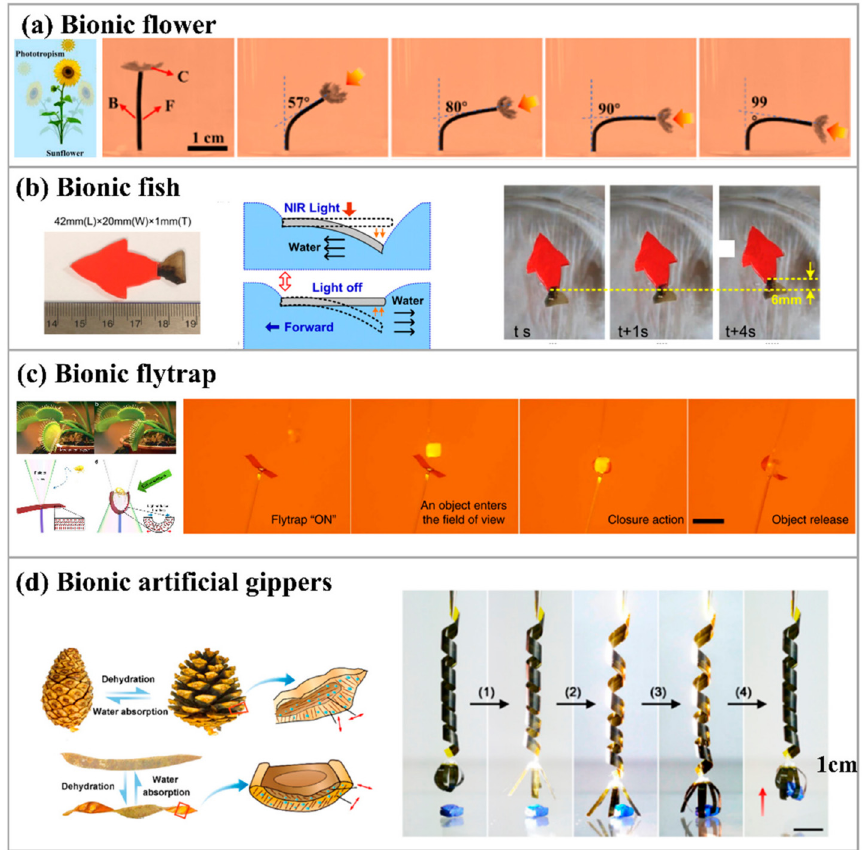
Figure 9. Nature-inspired light-powered soft robot. ( a ) Bionic flower prepared by flexible actua- tor [93]. Permission from RSC Publishing. ( b ) Fishtail-inspired robotic fish actuator design [83]. Permission from American Chemical Society. ( c ) Grasping robot inspired by flytrap [92]. Permission from Springer Nature. ( d ) Design and lifting process of the mechanical arm [47]. Permission from American Chemical